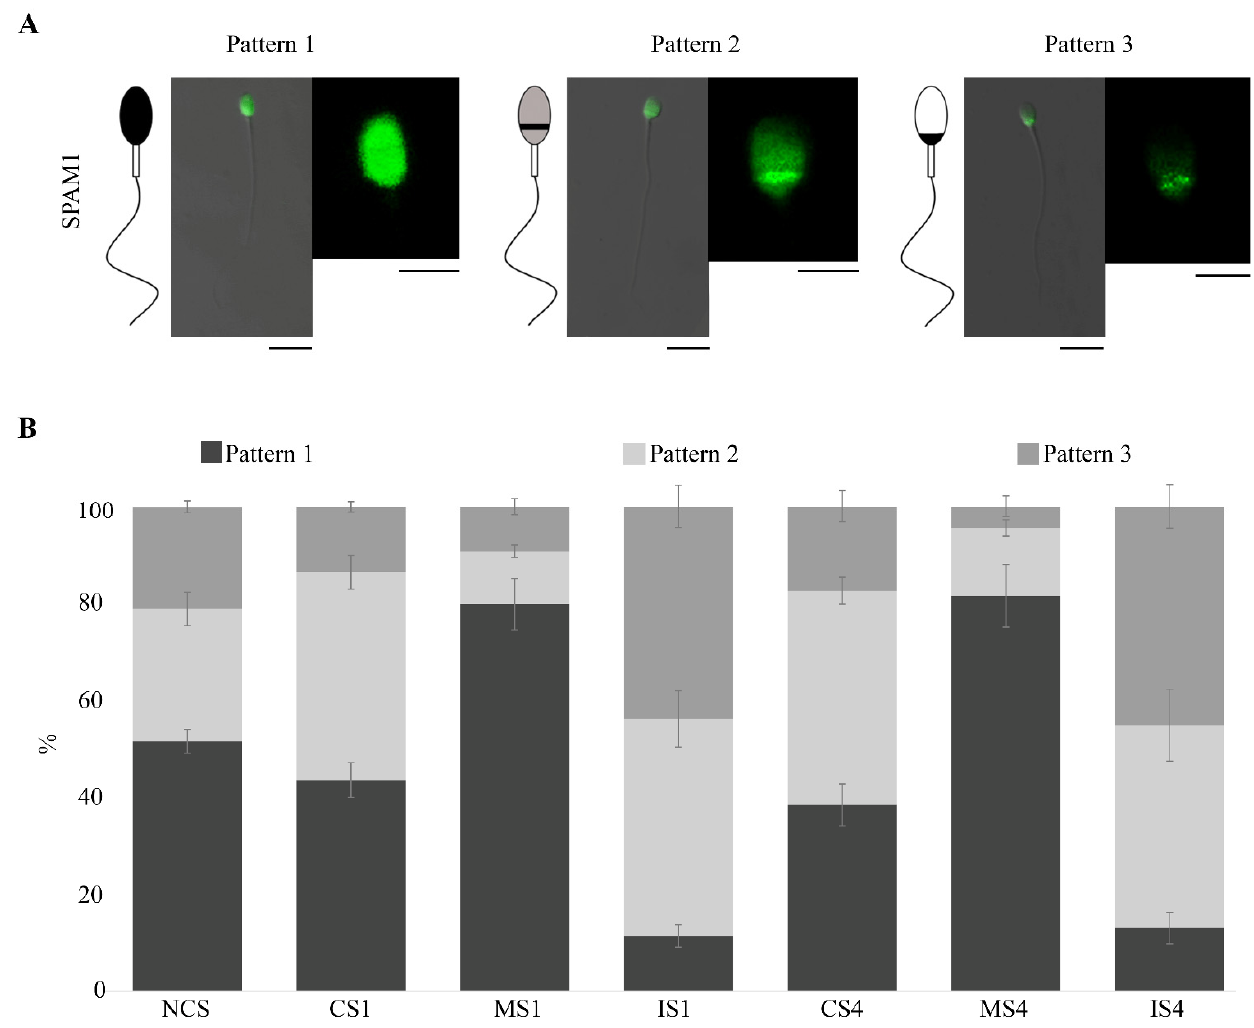
Figure 3. SPAM1 immunolocation results in human sperm. ( A ) Confocal micrographs of sperm SPAM1 patterns. Pattern 1, label throughout the head; pattern 2, equatorial segment with acrosomal faith label; pattern 3, postacrosomal label. Sperm scale 10 µm; head sperm scale 5 µm. ( B ) Percentages and error bars of SPAM1 patterns in each physiological condition. NCS, noncapacitated sperm; CS1, one-hour capacitated sperm; MS1 and IS1, mature and immature sperm selected by hyaluronic acid after one-hour capacitated; CS4, four-hour capacitated sperm; MS4 and IS4, mature and imma- ture selected by hyaluronic acid after four-hour capacitation.